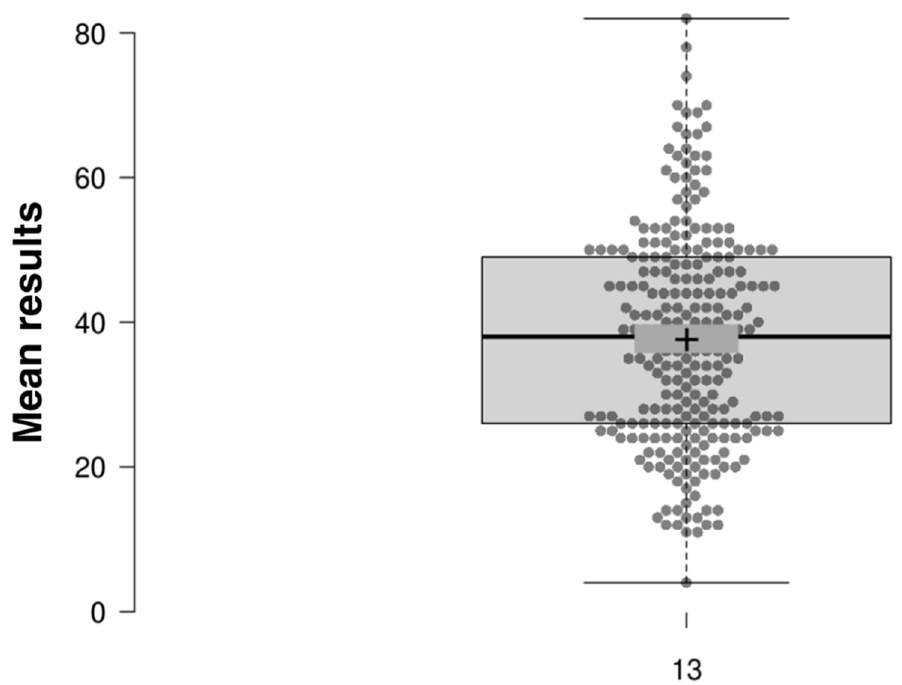
Figure 2. Distribution of global average scores in violin chart.